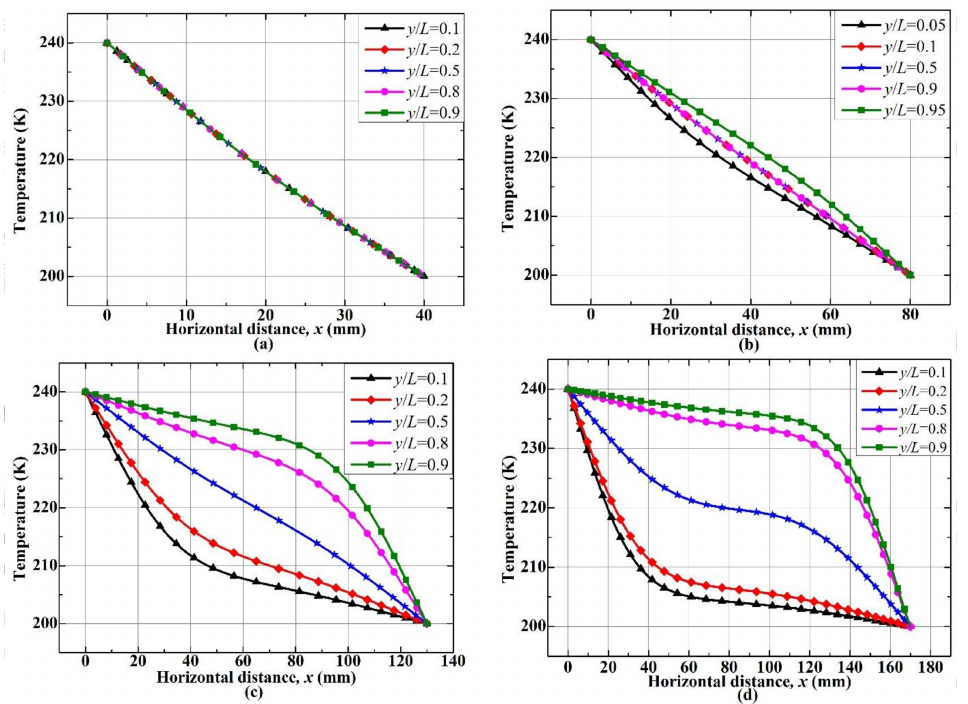
Figure 11. Variation in the vertical enclosure temperatures with horizontal distance at L = 1000 mm, ∆ T = 40 K: ( a ) H = 40 mm; ( b ) H = 80 mm; ( c ) H = 130 mm; ( d ) H = 170 mm.